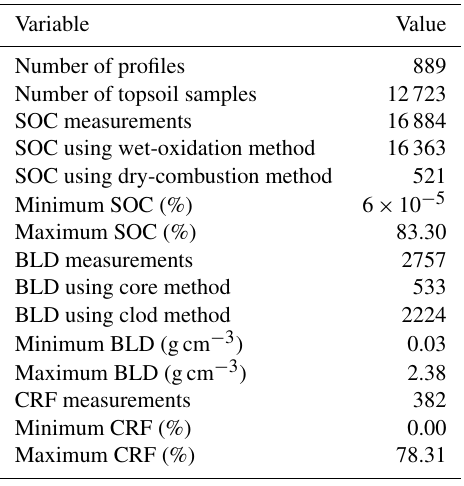
Table 2. Summary of the soil points included in the Chilean Soil Organic Carbon database